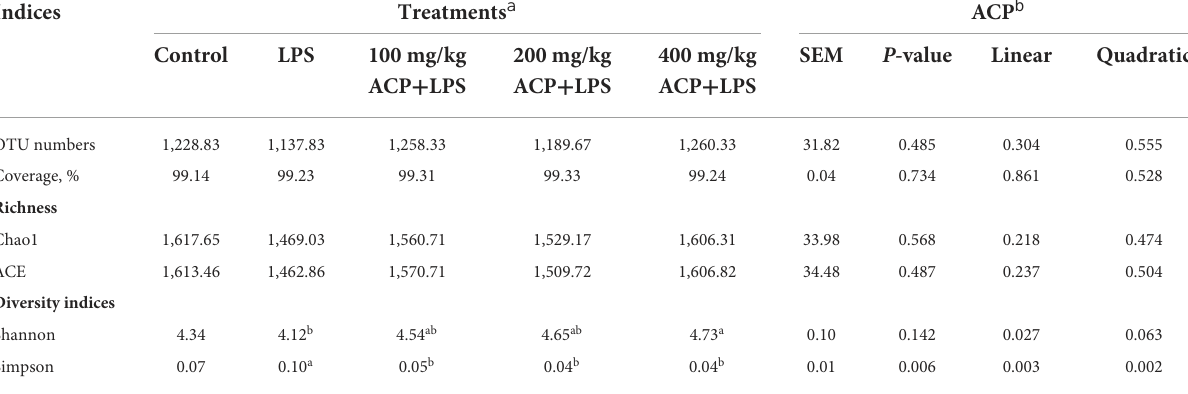
TABLE 6 Effects of Antrodia cinnamomea polysaccharide on Alpha diversity analysis of the microbiota from cecum of yellow-feathered chicken based on 97% sequence similarity. Indices Treatments